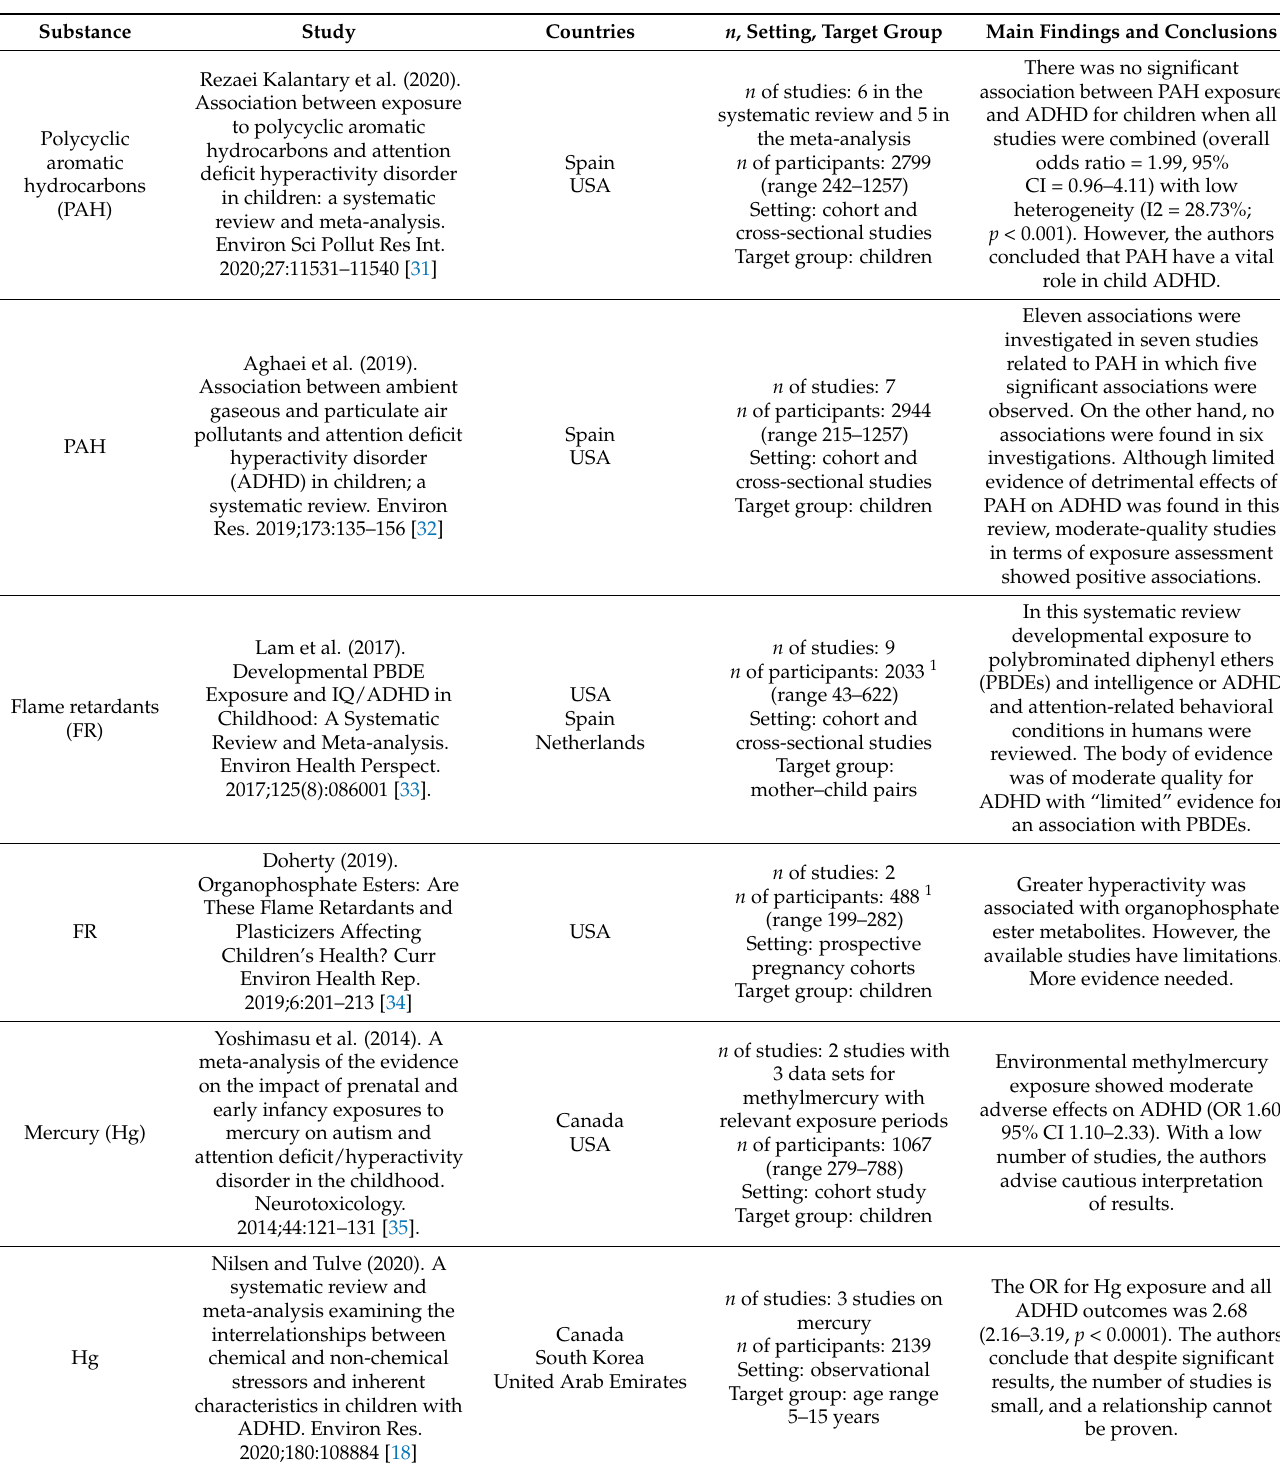
Table 2. Summary of studies providing evidence of limited association between ADHD and